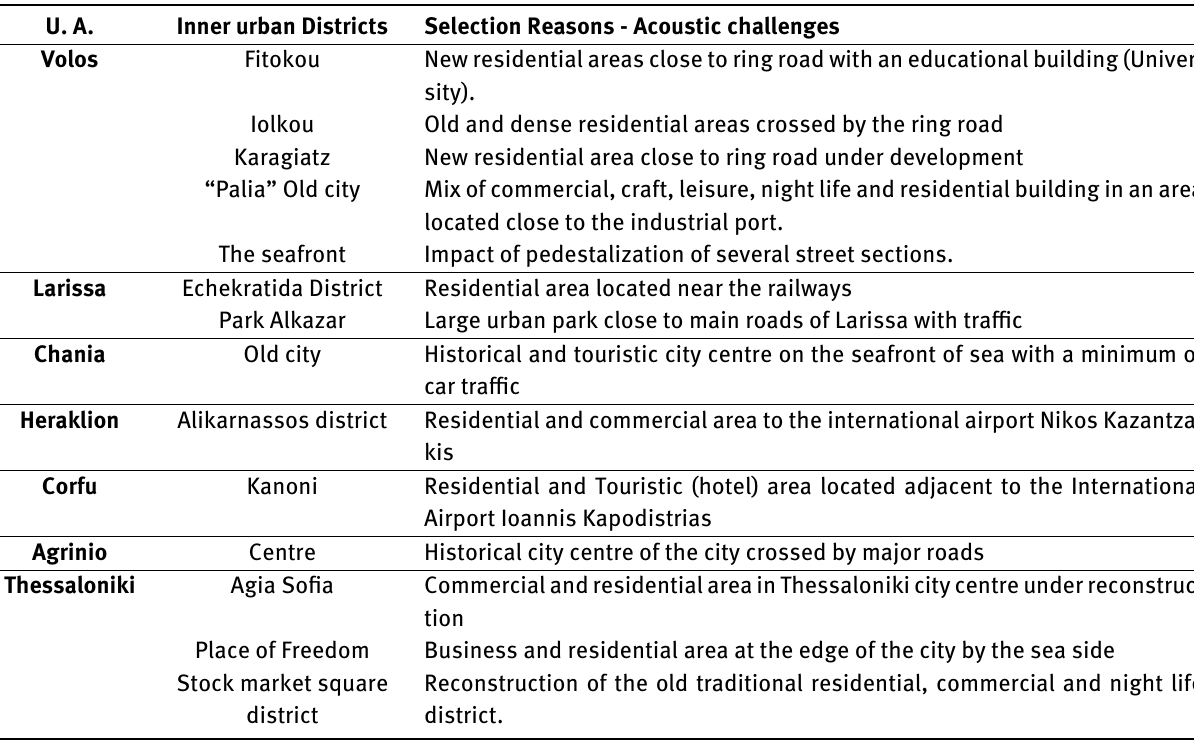
Table 2: Acoustic challenges short description of the selected districts selected in UA. U.